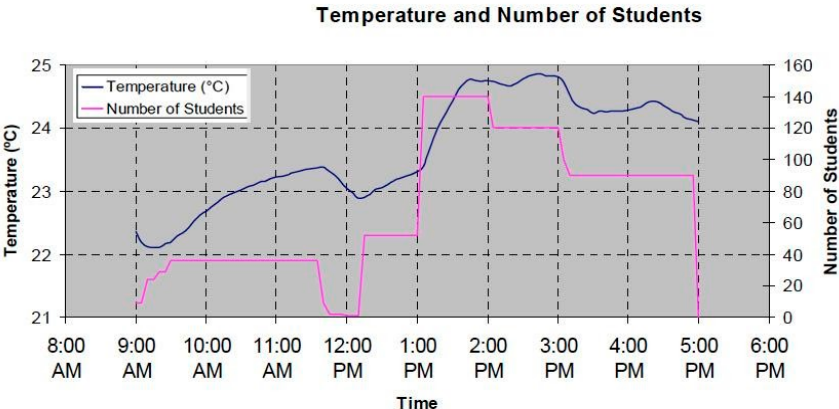
Figure 3. Measured temperature increase due to the addition of occupants in the classroom.